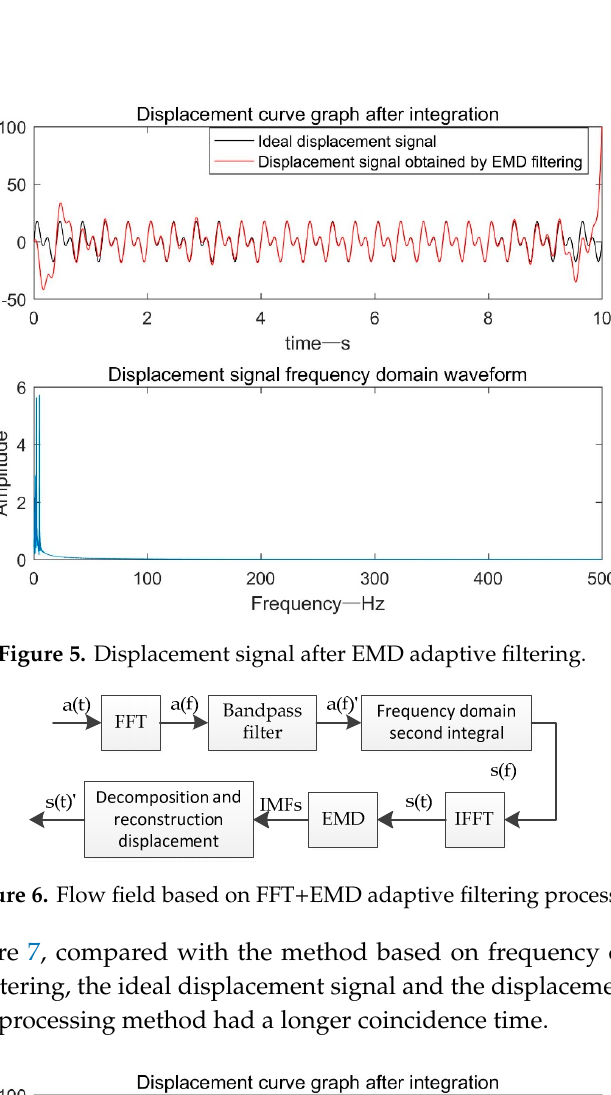
Figure 6. Flow field based on FFT+EMD adaptive filtering process.